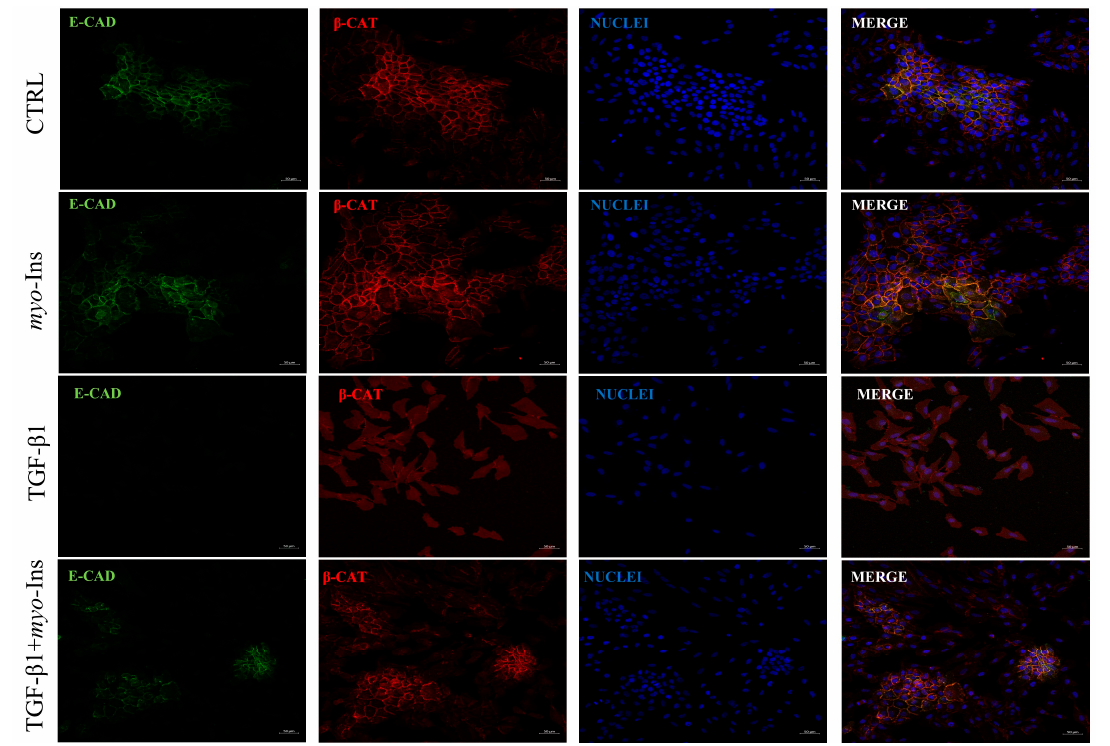
Figure 9. Analysis of E-cadherin and β -catenin distribution. Immunofluorescence analysis of E-cadherin (green) and β -catenin (red) in MCF-10A cells. The experimental conditions are depicted as control, myo-Ins treated, TGF- β 1 treated, and cells treated with TGF- β 1 plus myo-Ins. Nuclei were stained with TO-PRO3 (blue). The images were scanned under a 20× objective. In TGF- β 1 treated samples, cells lose E-cadherin– β -catenin complexes, while β -catenin migrates in the cytosol and E-cadherin was dramatically downregulated. Cells are detached from each other and dispersed over the entire area. The addition of myo-Ins following TGF- β 1 almost completely restores the physiological architecture of cell-to-cell contact with the reappearance of E-cadherin/ β -catenin complexes. Cells recover their junctions and assume a compact, tissue-like pro fi le, losing almost entirely stress fi bers.